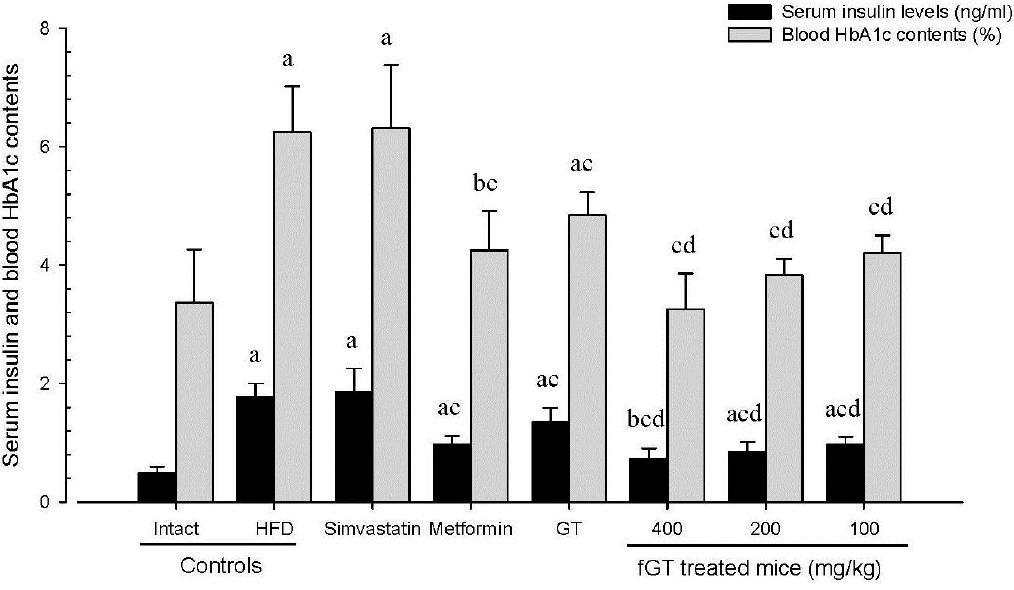
Figure 5. Serum insulin and blood HbA1c contents in NFD or HFD supplied mice. Values